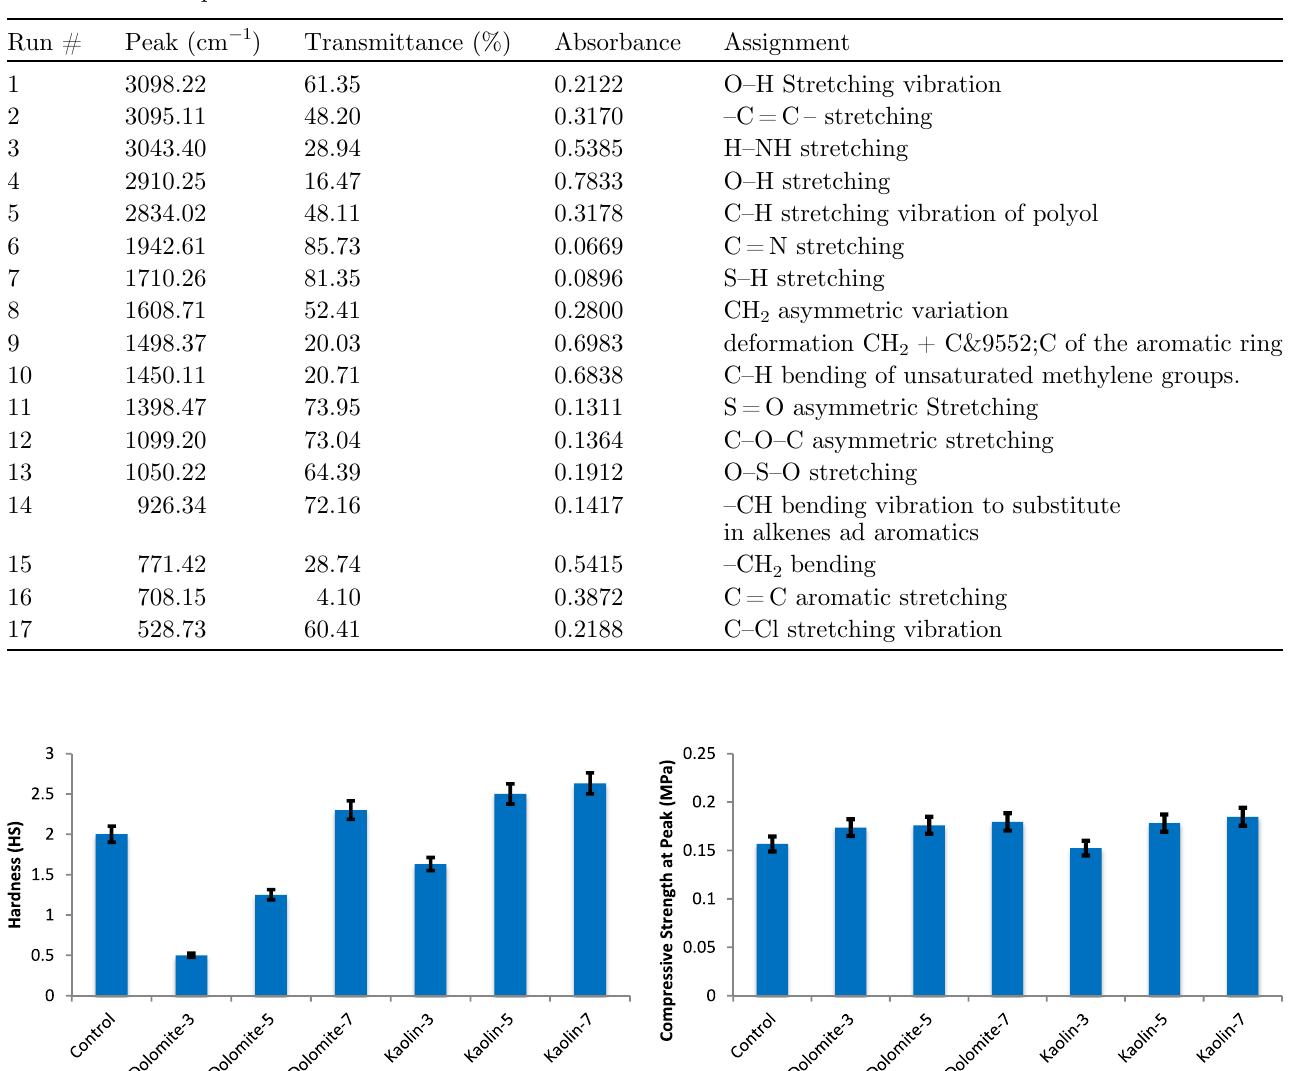
Fig. 5. Hardness property of the dolomite and kaoline fi lled polyurethane